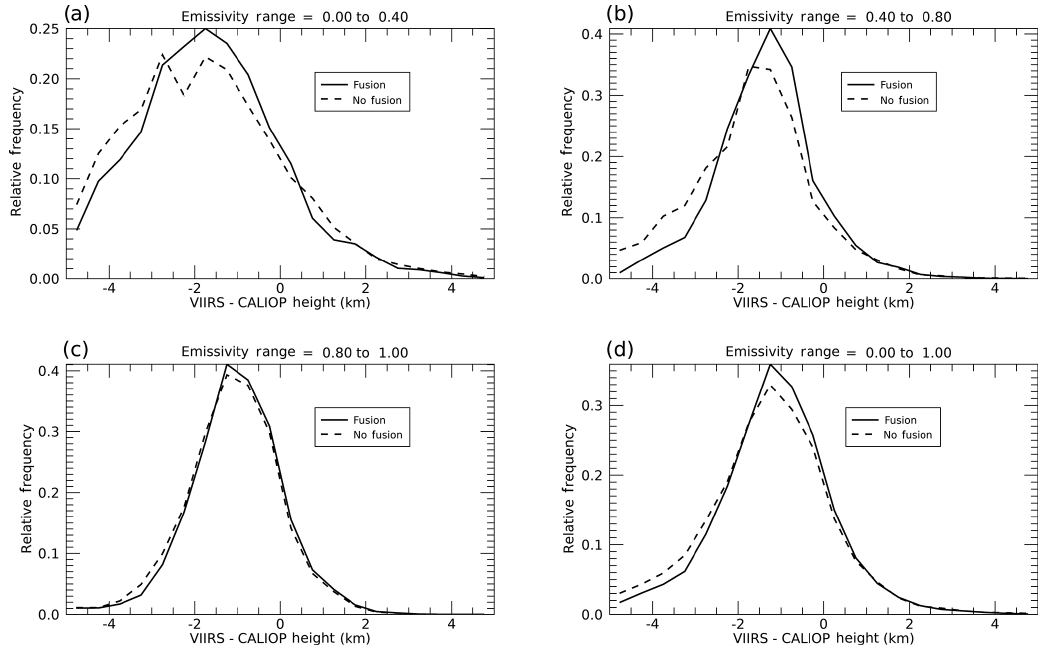
Figure 6. Bias distribution of cloud top height between NOAA-20 VIIRS and CALIPSO/CALIOP for emissivity ranges of (a) 0 to 0.4; (b) 0.4 to 0.8; (c) 0.8 to 1.0; and (d) 0 to 1.0. Solid and dashed lines indicate data with and without fusion channels.